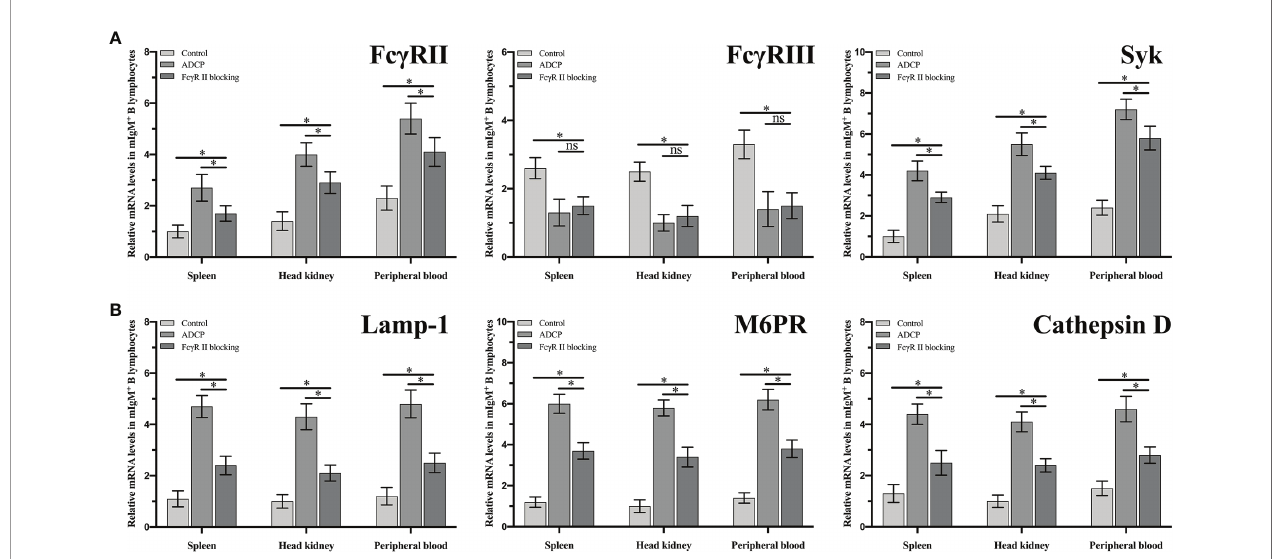
FIGURE 9 | The expression levels of ADCP-related (A) and phagolysosome-related (B) genes in FcgRII blocked and unblocked mIgM+ B lymphocytes after phagocytosis. Error bars indicate the standard deviation of the three biological replicates. ns, no signi fi cant difference. The asterisks on the bars represent the statistical difference of genes expression compared to the control group (p <